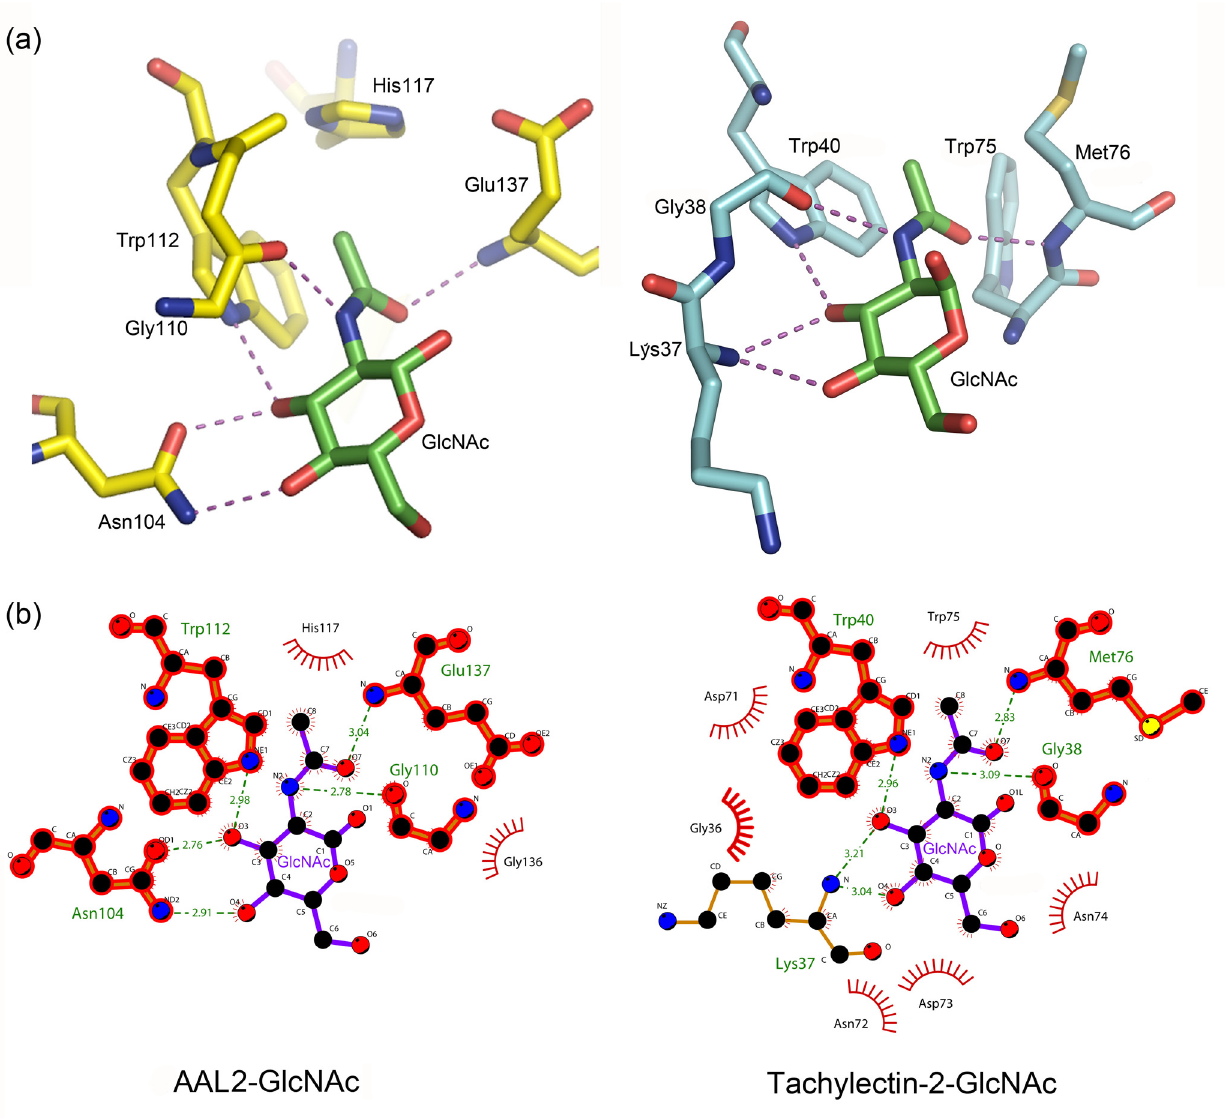
Fig 5. (a) The comparison of hydrogen bonds network between AAL2 (left) and Tachylectin-2 (right) and GlcNAc. (b) Both polar and hydrophobia interactions between AAL2 (left) and Tachylectin-2 (right) and GlcNAc. GlcNAc is shown in purple and the residues that are marked bold show the same components of the glycan binding pockets in the two